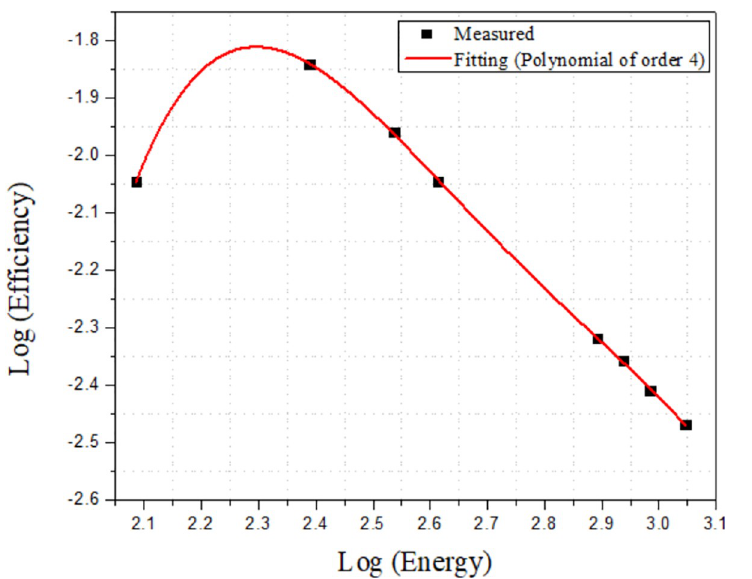
Fig 3. Energy efficiency of HPGe detector (standard point source 152